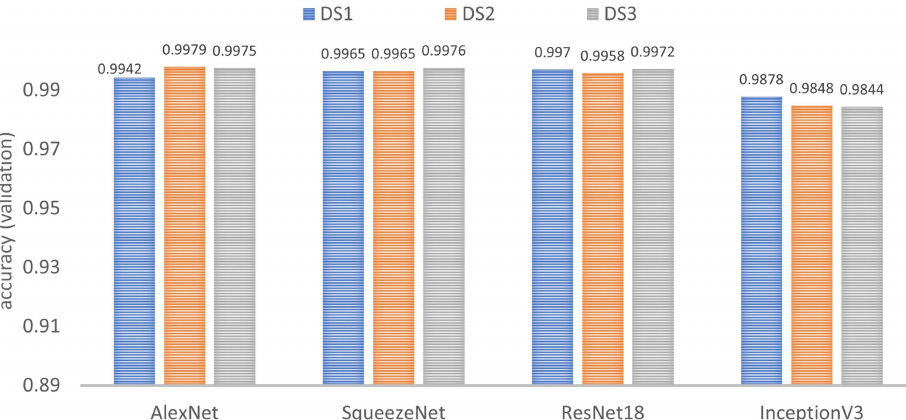
Figure 16. Comparison of four TL-based models in terms of dataset organization (DS1, DS2,